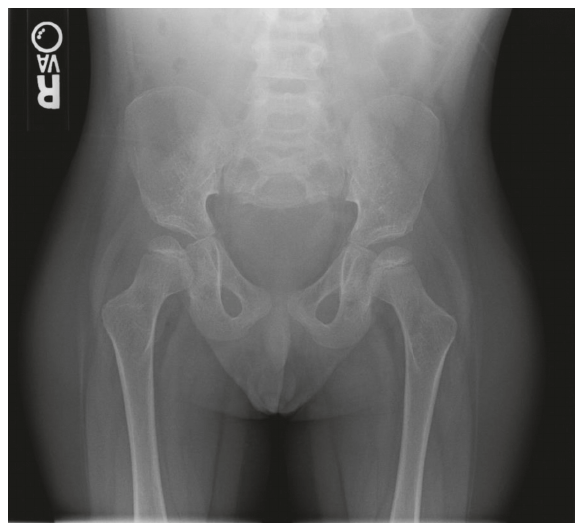
Figure 1: Skeletal survey revealing truncation of the caudal sacrum.